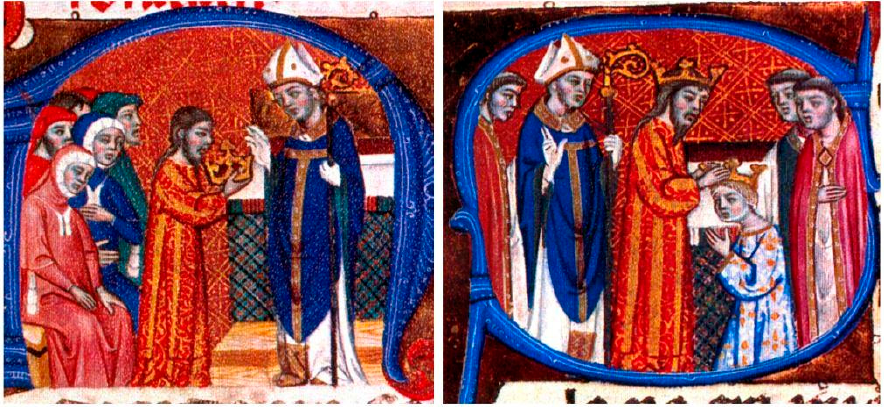
Figure 4. Ceremonial de consagración y coronación de los reyes de Aragón . Ms. 14425, fols. 19r and 35v. Second half of 15th century. © Fundación Lázaro Galdiano. Both illuminations show the most important moment of the ceremonies; that is, when the king takes the for himself crown and when the king places the crown on the new queen’s head. Permission granted.